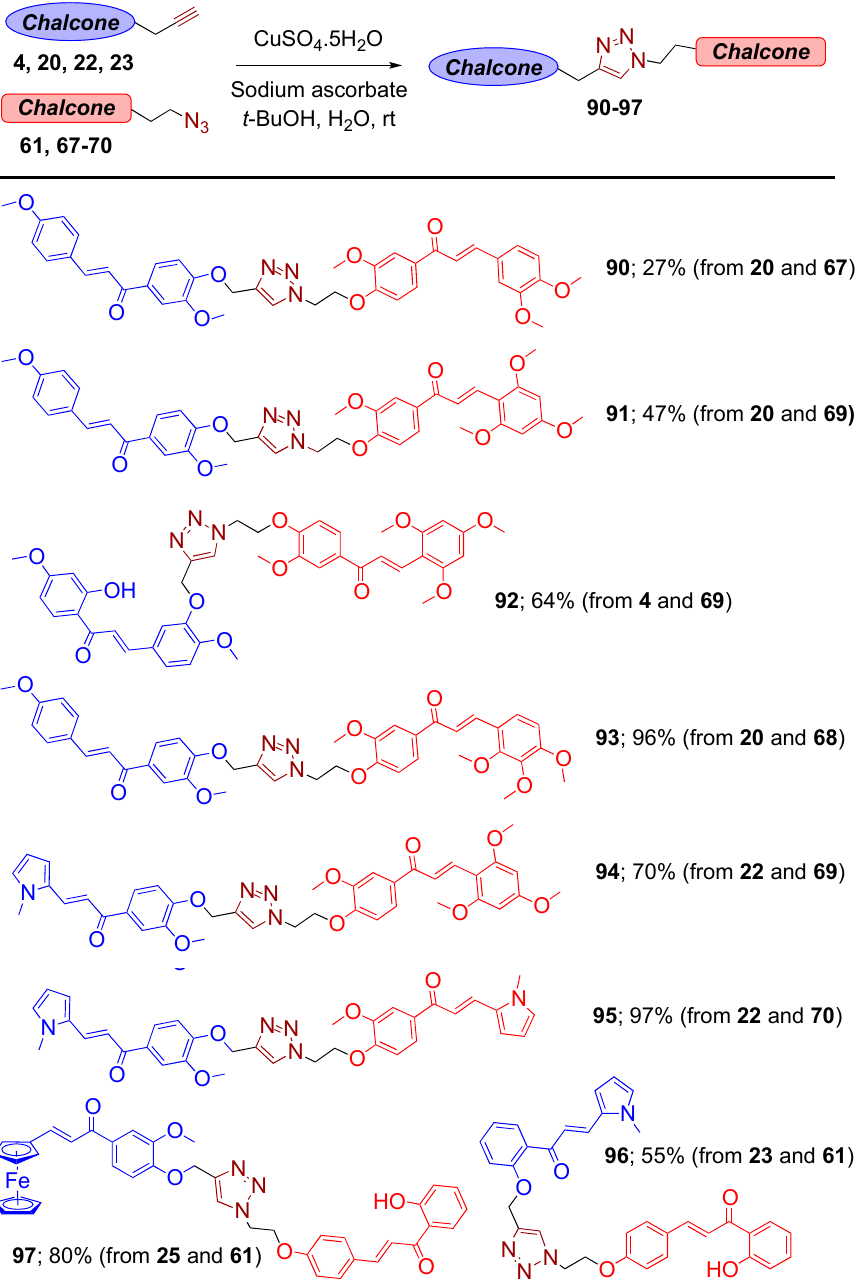
Scheme 16. Synthesis of triazole-bridged chalcone-chalcone dimers.